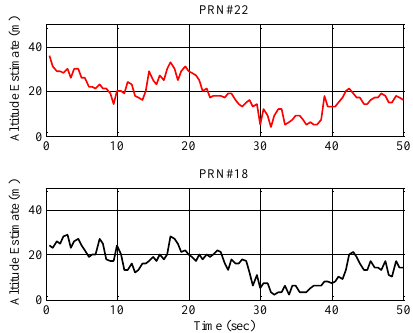
Figure 17. Surface height estimates using signals associated with two satellites (PR#22 and